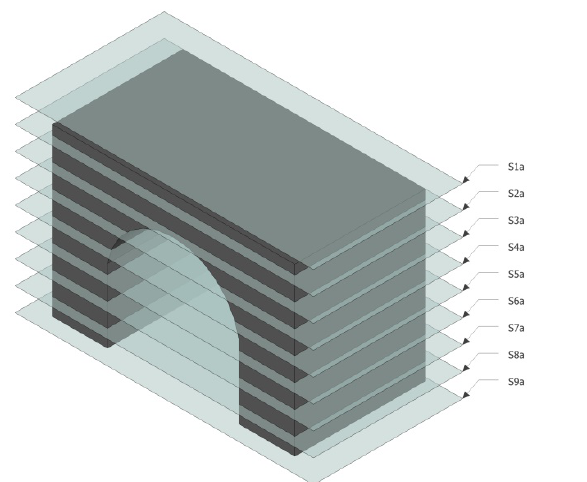
Figure 6. New displacement of the